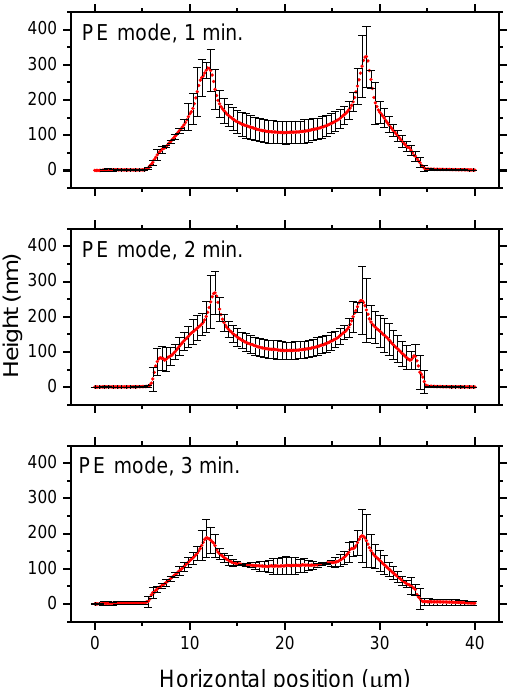
Figure 7. Height profiles of the patterned PEDOT:PSS lines made by plasma-treating the photoresist in plasma etching (PE) mode before spin-coating PEDOT:PSS. The error bars show the maximum and minimum values at each position.